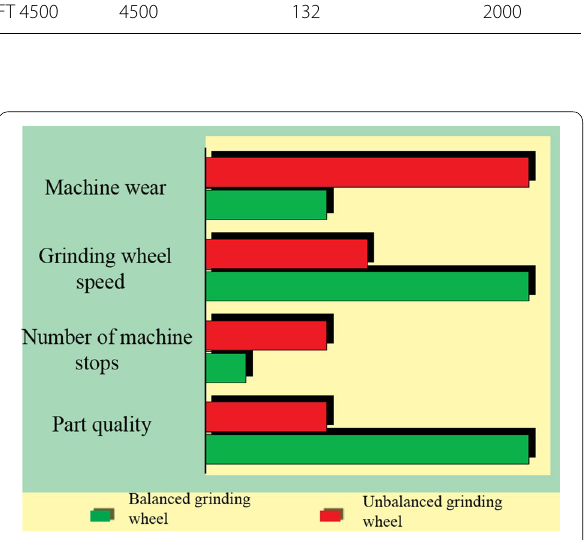
Figure 8 Comparison of the effect before and after dynamic balance of grinding